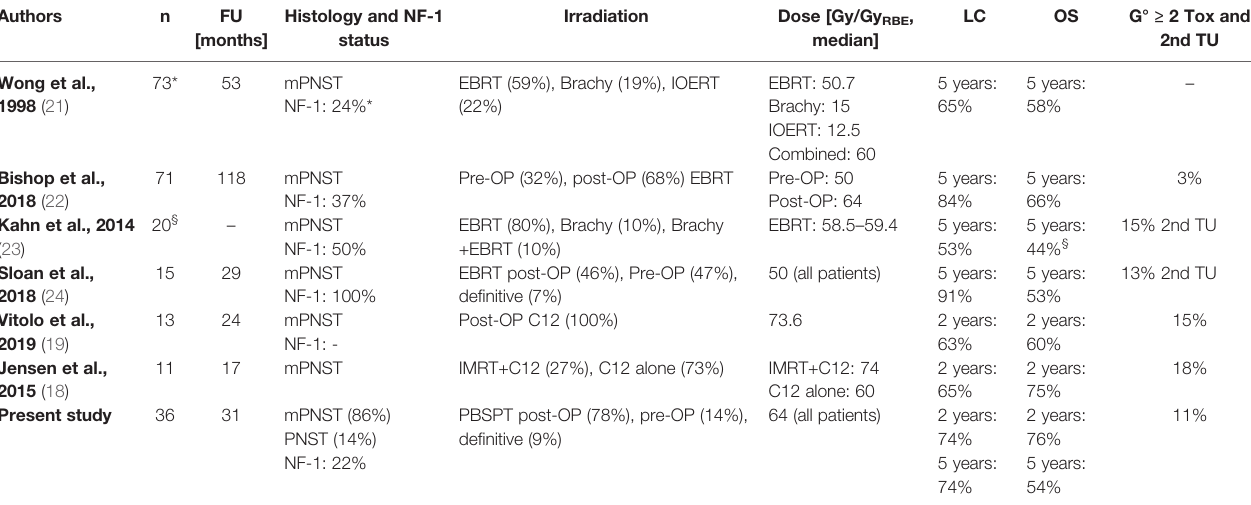
TABLE 5 | Summary of studies detailing the outcome after irradiation of